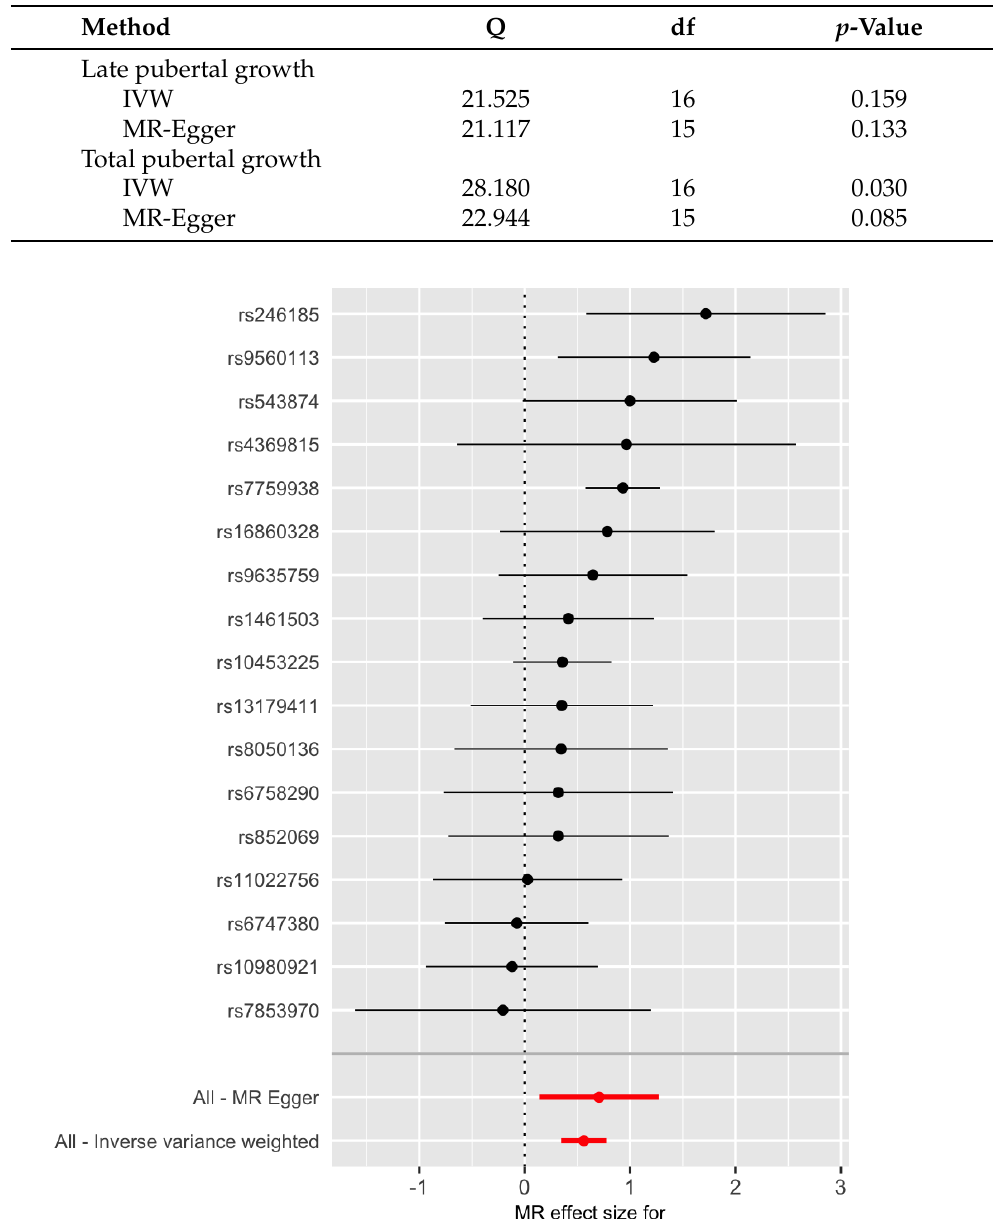
Table 2. Results of Cochran’s Q test on the heterogeneity of instrument SNPs.